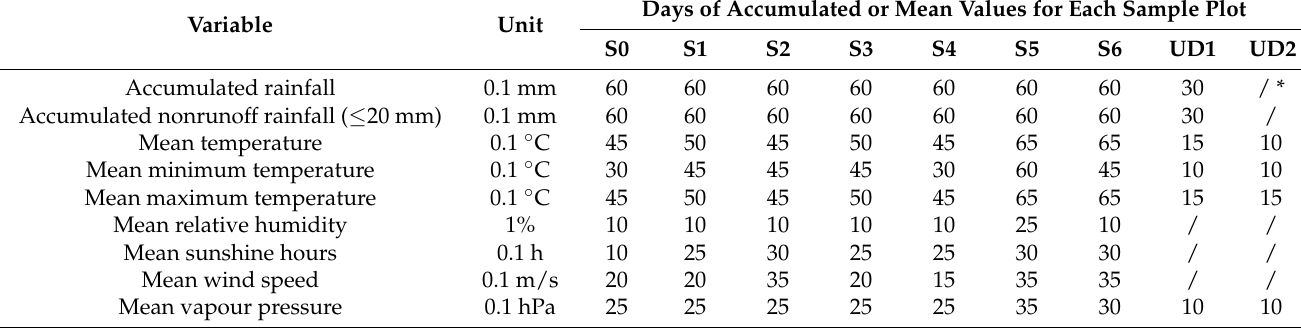
Table 3. Accumulation periods of each variable in each